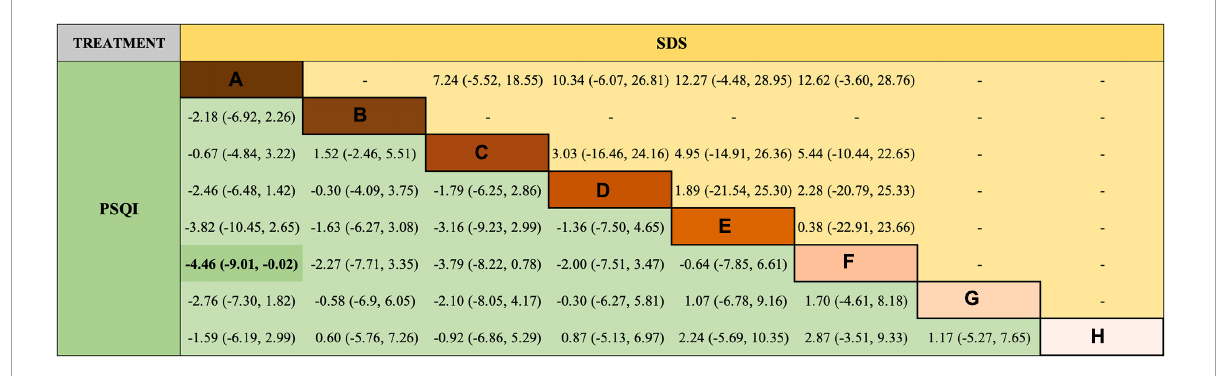
FIGURE5 Network meta-analysis results of Pittsburgh Sleep Quality Index (PSQI) and Self-Rating Depression Scale (SDS). A = antiepileptics; B = manual acupuncture; C = electroacupuncture; D = fire needling; E = pricking and cupping; H = electroacupuncture plus antiepileptics; I = fire needling plus antiepileptics; K = acupoint catgut embedding plus antiepileptics.